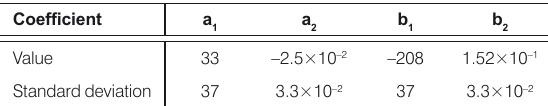
Table 3. Regression coefficients and their standard deviations for Eq.